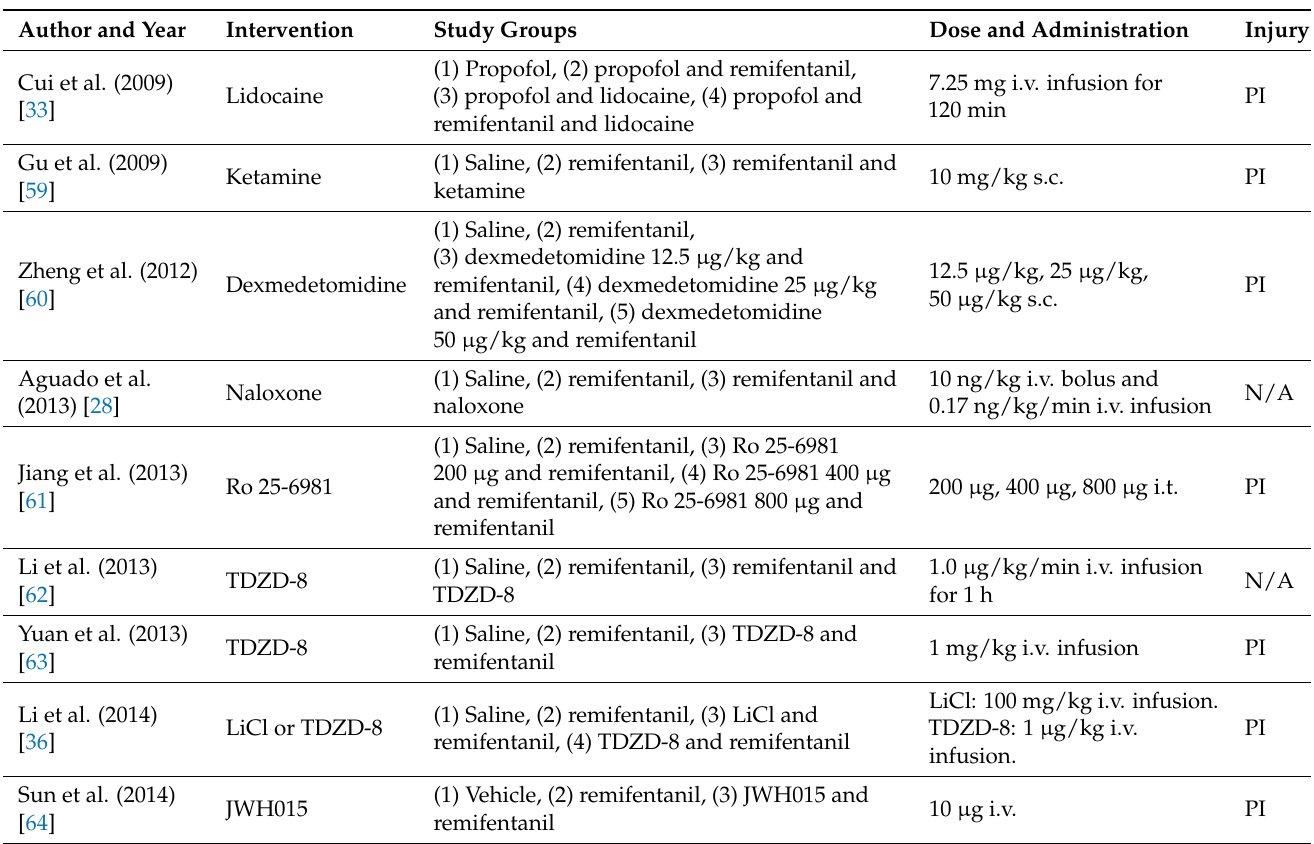
Table 1. Main characteristics of remifentanil trials. Intervention, study groups, intervention dose, administration method and injury model used in 27 trials. #: experimental group was not statistically different compared to the opioid-only group. i.v.: intravenous. s.c.: subcutaneous. i.t.: